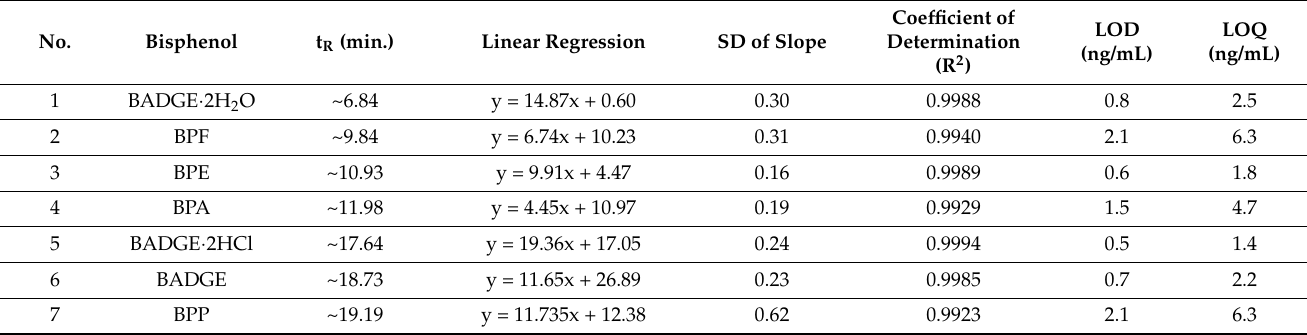
Table 1. Method validation parameters obtained from calibration curves in averaged human breast milk sample ( n = 10): time retention, linear regression, coefficient of determination, standard devia ‐ tion (SD) of slope, limit of detection, limit of quantification.